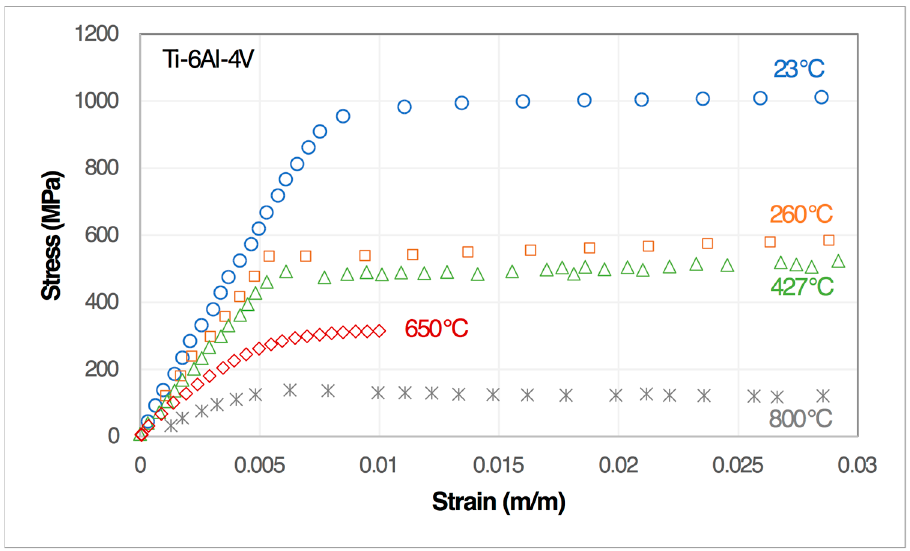
Figure 3. Uniaxial stress-strain curves for Ti-6Al-4V matrix material.